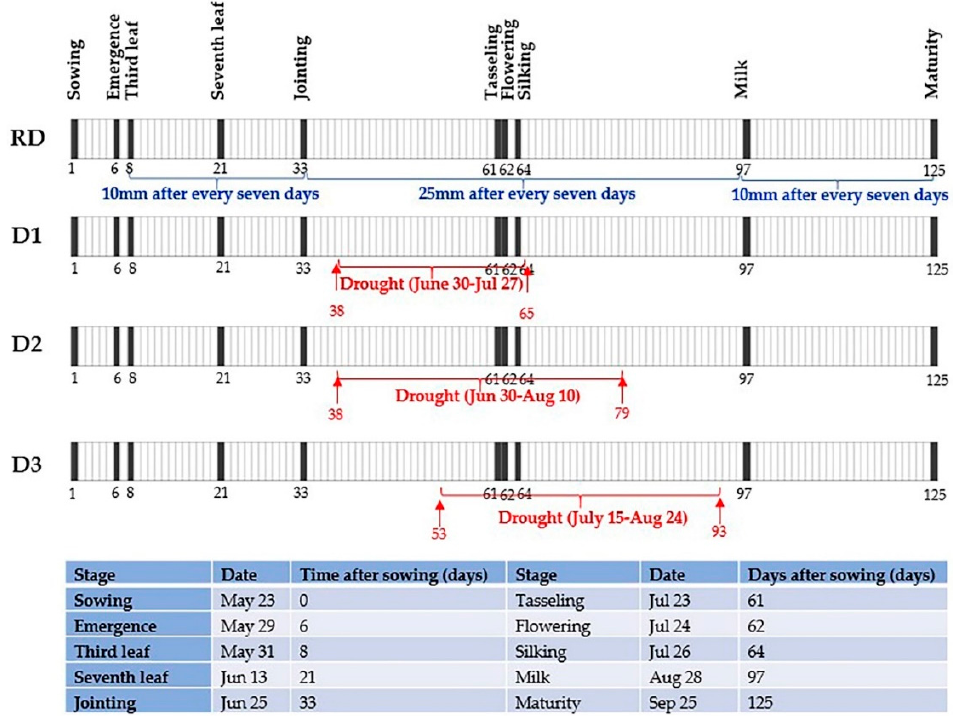
Figure 1. Critical points of growth and drought treatments of spring maize of Northeast China.